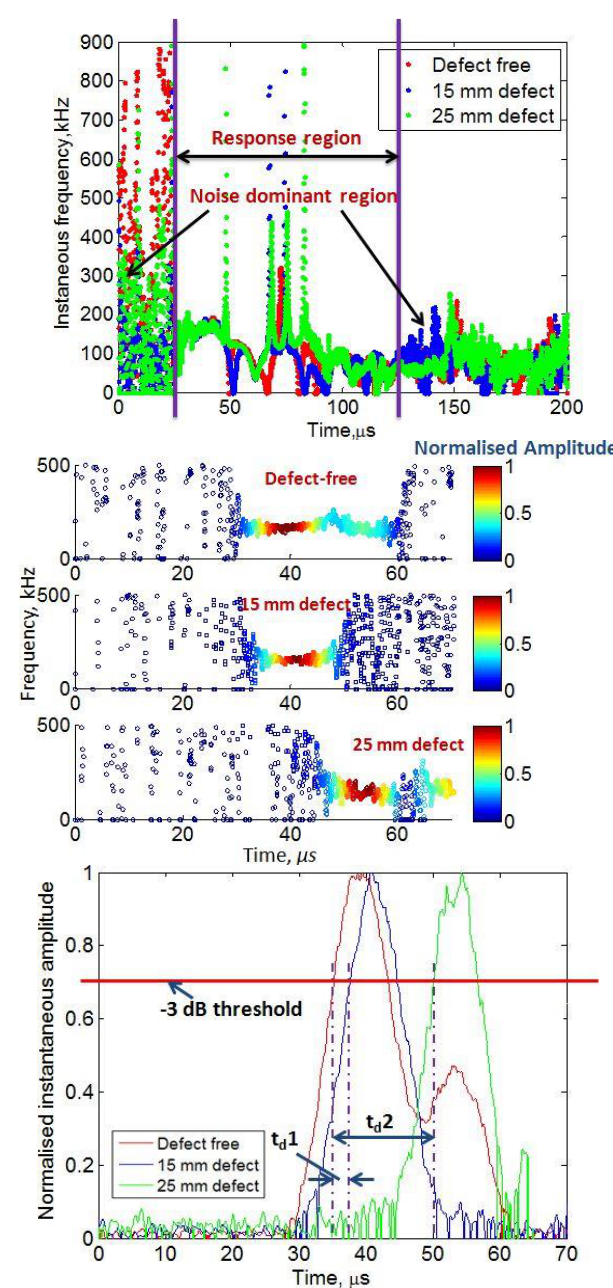
Figure 11. Instantaneous characteristics of defective and defect-free signals using HHT: ( a ) time–frequency characteristics of reconstructed signals (IMF6-IMF12); ( b ) Hilbert–Huang spectrum of IMF6; ( c ) the normalized characteristics of instantaneous maximum amplitude of Hilbert–Huang spectrum of IMF6.